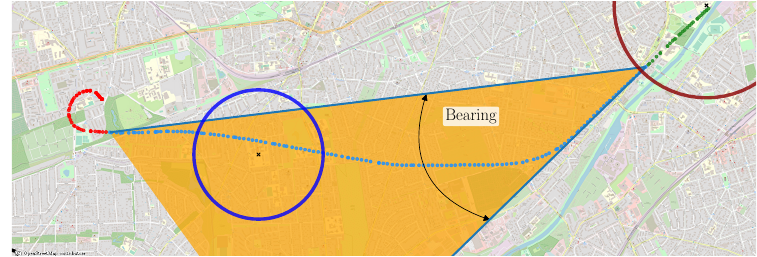
1 Figure 3. Example flight with illustration of the bearing